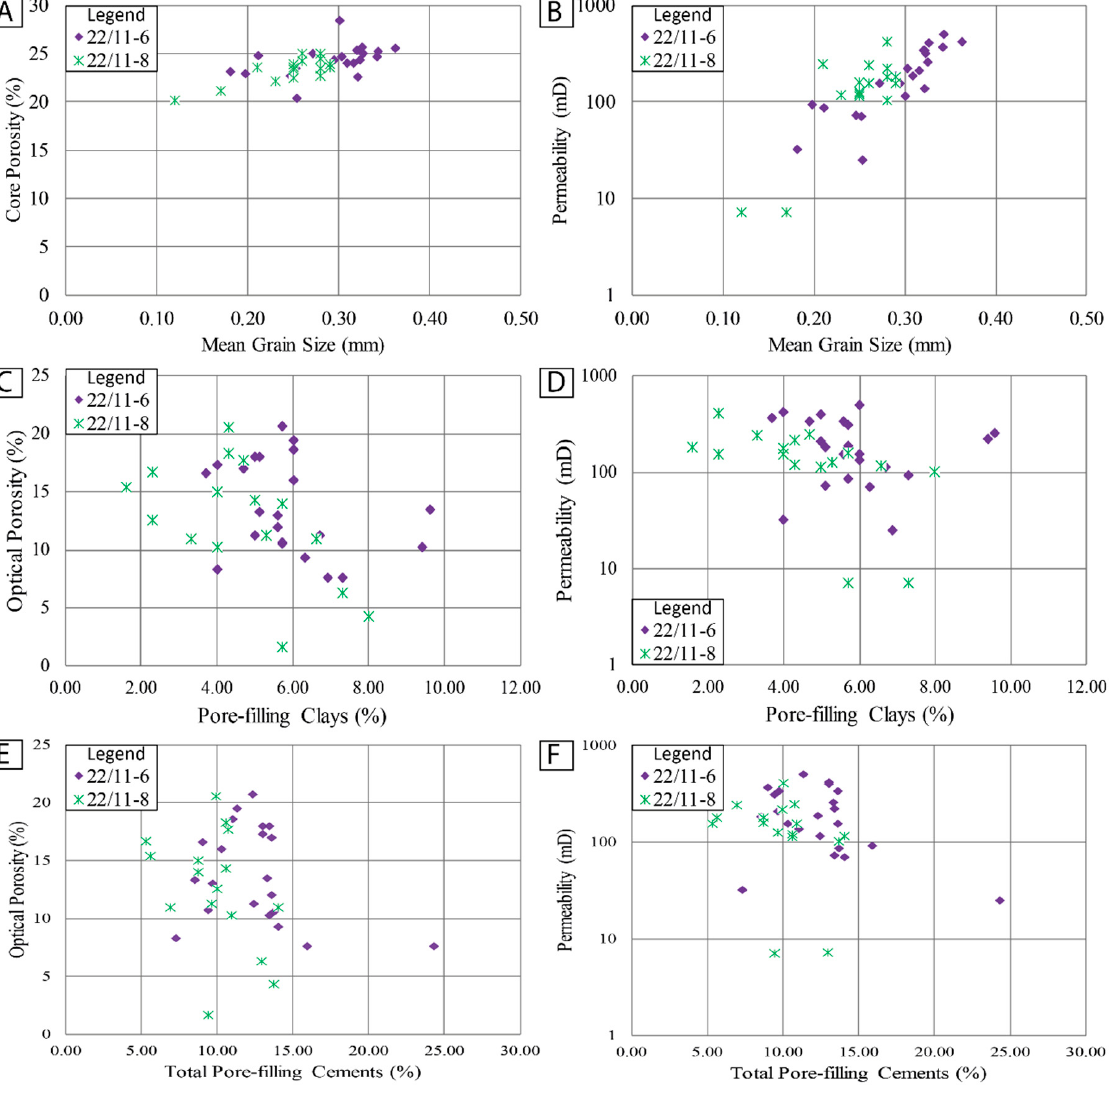
Figure 11. Impact of depositional characteristics (e.g., grain size), pore-filling clays, and cements on reservoir properties of the Forties Sandstone Member. ( A , B ) plots of porosity against grain size and permeability against grain size, respectively. ( C , D ) plots of porosity against pore-filling (authigenic) clays and permeability against pore-filling (authigenic) clays, respectively. ( E , F ) plots of porosity against total pore-filling cements and permeability against total pore-filling cement, respectively.